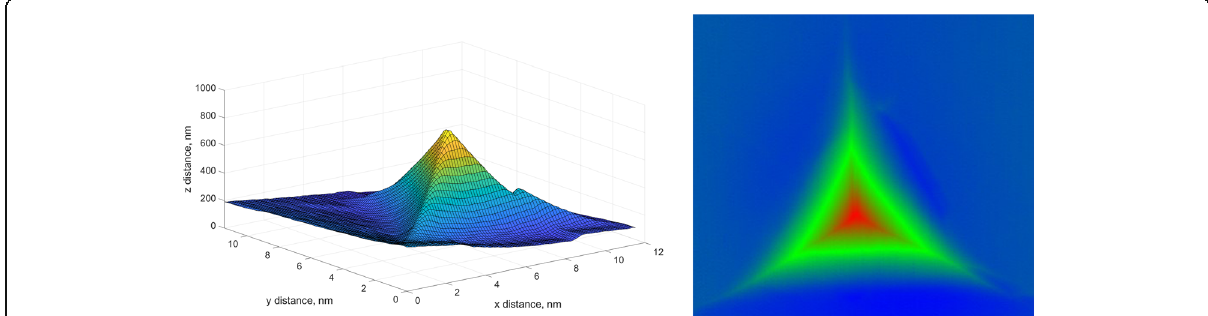
Fig. 3 Investigation of fracture toughness inverted 3D image (left) and residual impression (right)